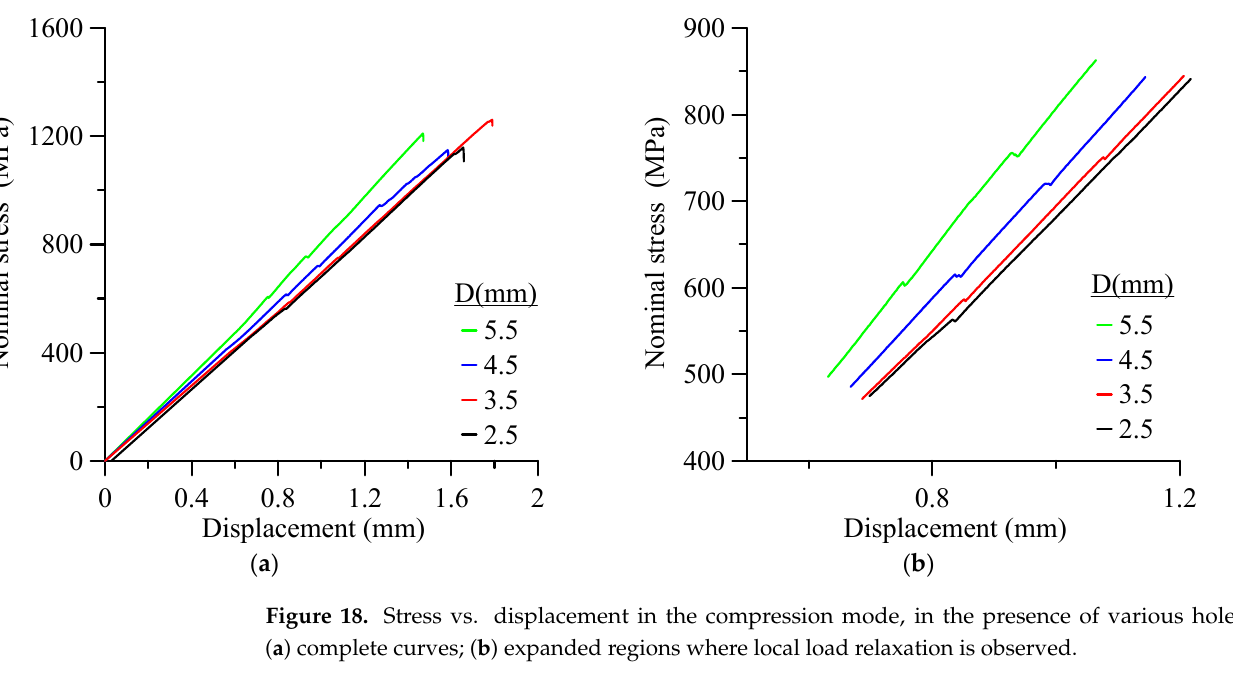
Table 6. Mechanical properties of holed coupons in the compression mode of loading.